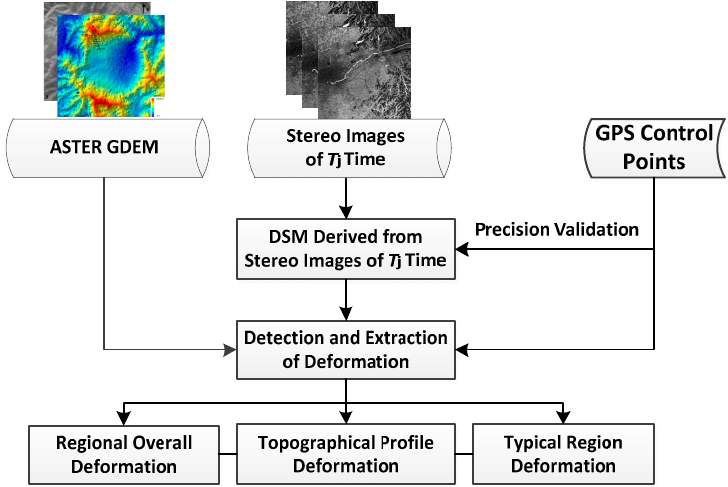
Figure 3. Main procedure of ground deformation extraction using ZY-3 stereo images.